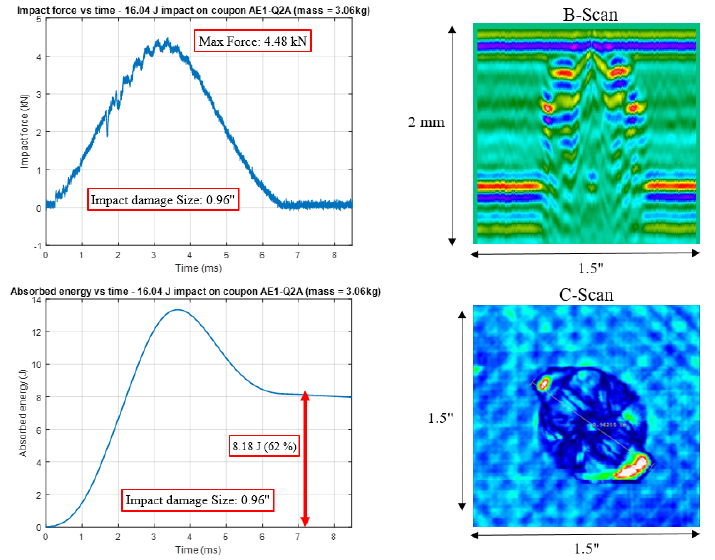
Figure 10. Impact results of 2 mm coupon AE1-Q2A consisting of force-time plot, energy-time plot, B-scan and C-scan from UT.